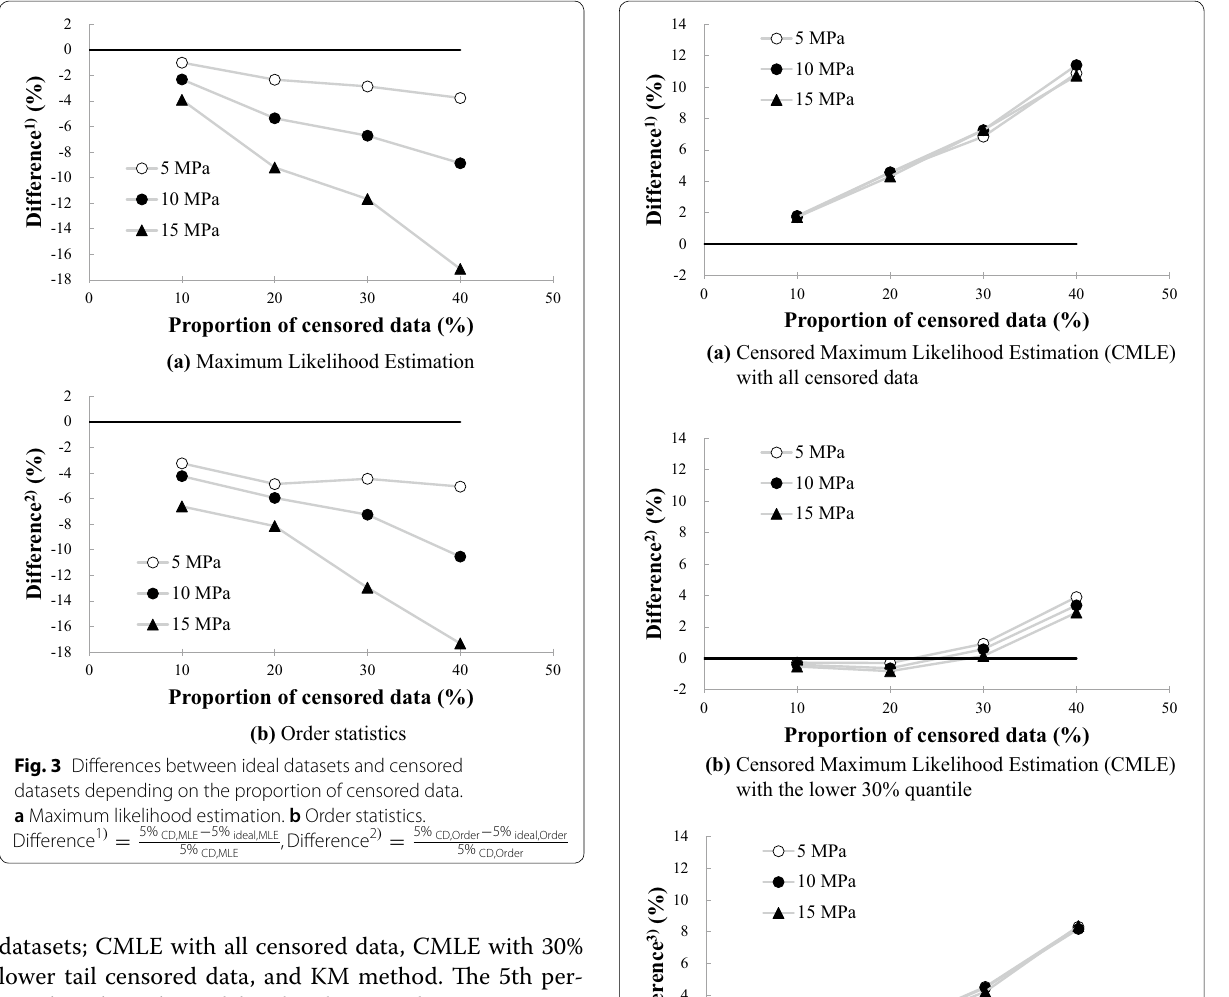
datasets; CMLE with all censored data, CMLE with 30%